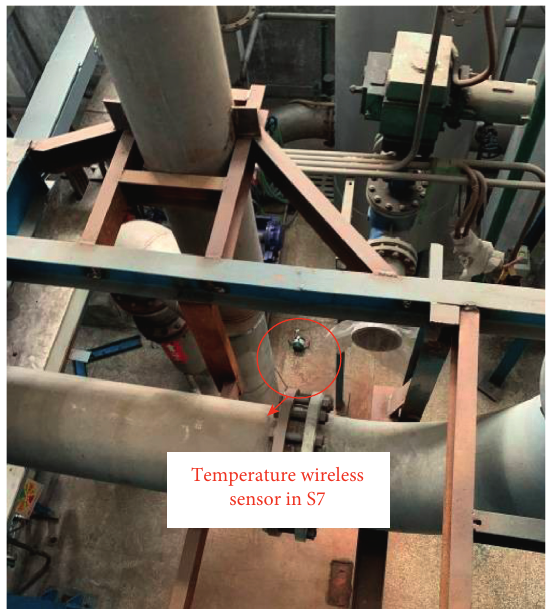
Figure 18: Display of the wireless temperature sensor at the S7 position on the first floor of the